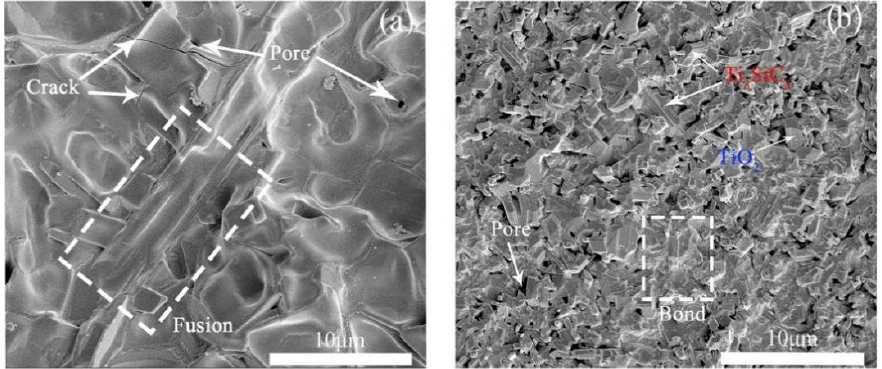
Figure 4. Surface morphology of the oxide layer after oxidation of ( a ) TSC60 and ( b ) TSC50 at 1400 °C for 4 h.